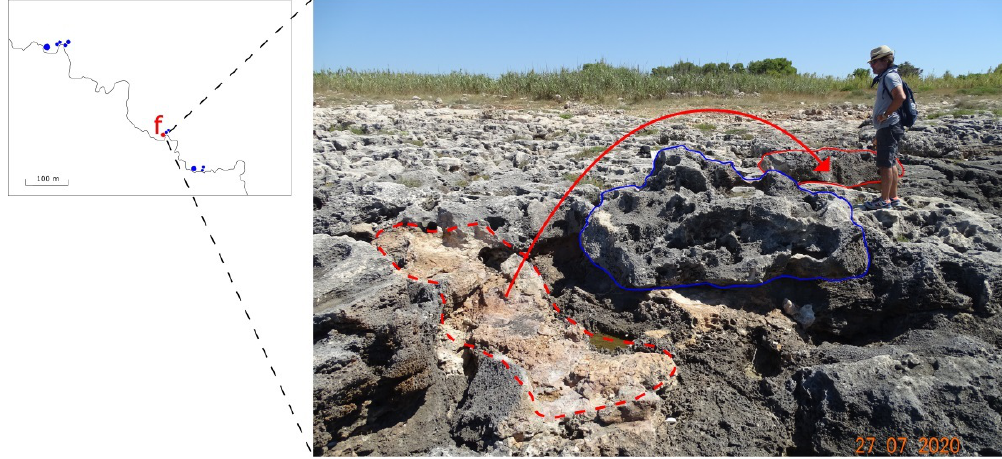
Figure 9. The saltation movement of Boulder e; the socket (red dashed) and the final position (red solid) are shown; the blue line highlights Boulder